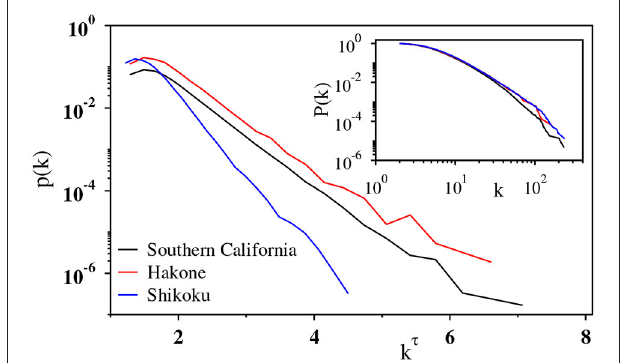
FIGURE 4 | Plot of the degree distribution p ( k ) against k τ , with k being the degree of the nodes, on a semilog scale for the time series of Southern California (black), Hakone (red), and Shikoku (blue). The τ values are 0.364, 0.364, and 0.280, respectively. The plot indicates exponential decay of all the curves. For visual clarity, a linear shift is given to the black curve [ p ( k ) Inset: log-log plot of the cumulative degree distribution P ( k ) for the corresponding data sets displaying systematic curvatures of the curves.